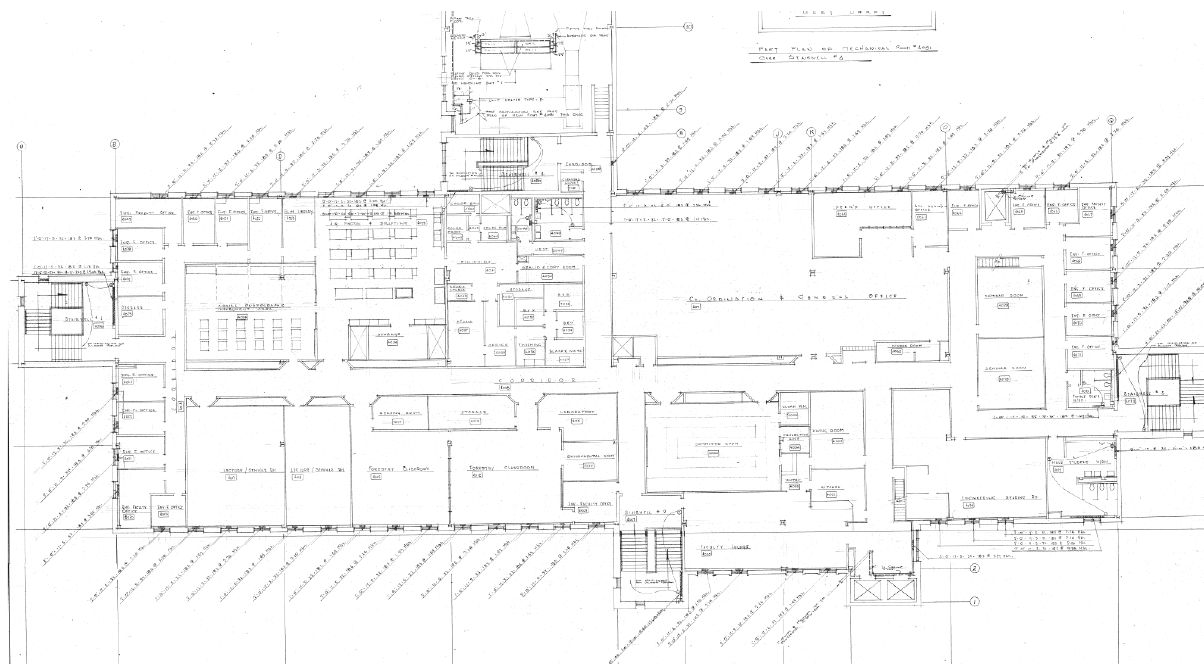
Figure 6: Fourth-floor